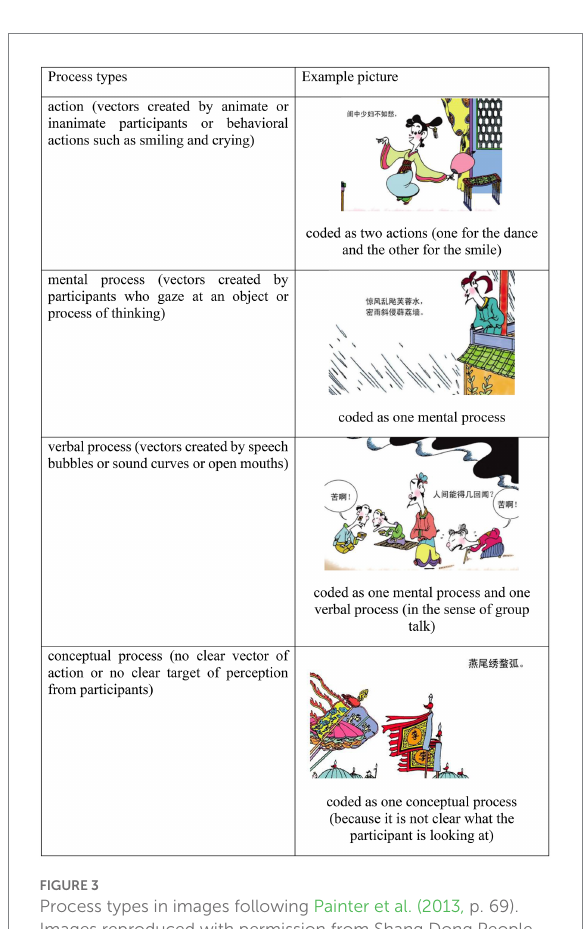
FIGURE 3 Process types in images following Painter et al. (2013, p. 69). Images reproduced with permission from Shang Dong People Press.